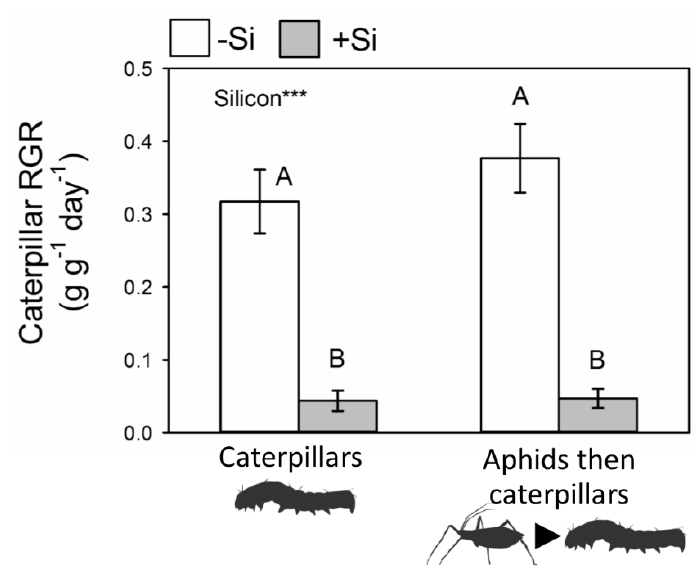
Figure 4. The effects of Si and previous aphid herbivory on relative growth rates (RGR) of H. armigera . Results of statistical analysis: Si: F 1,36 = 59.54, p < 0.001; Aphids: F 1,36 = 1.83, p = 0.185; Si × Aphids: F 1,36 = 0.18, p = 0.675. Significant treatments indicated *** p < 0.001 and uppercase letters used to indicate differences between treatments. Mean ± SE shown ( n = 10).